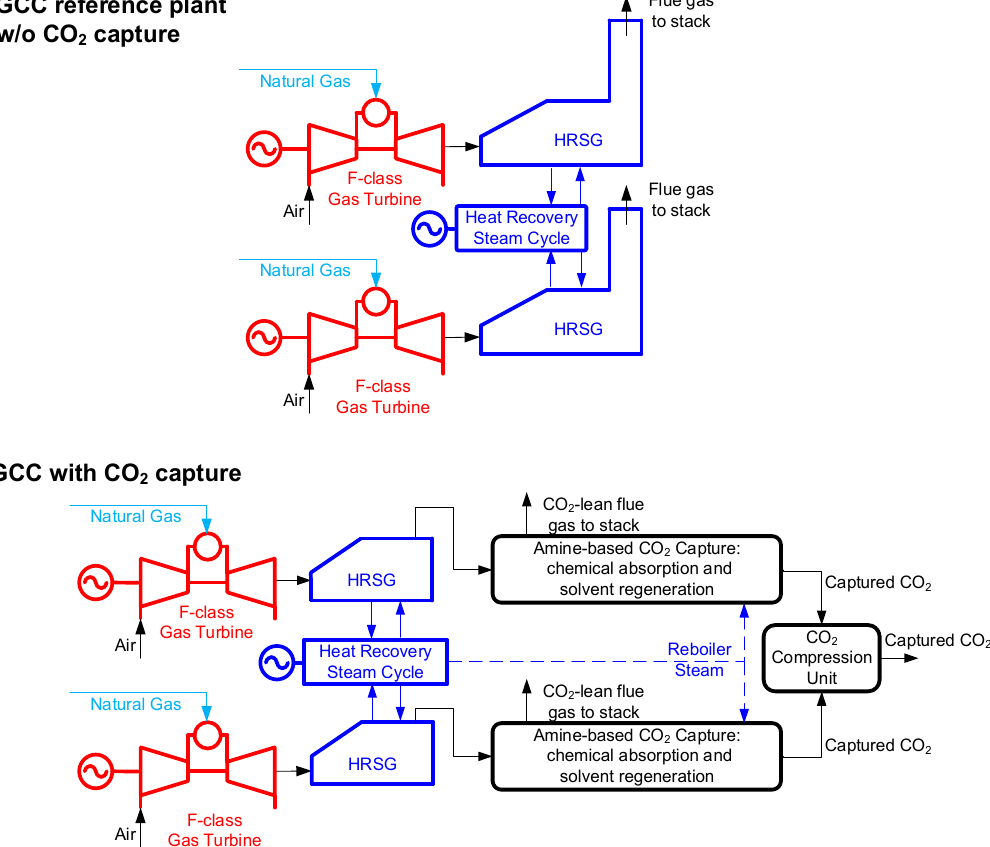
Figure 2. Block-flow diagram of: ( a ) the Reference plant without CO 2 capture and storage (CCS); ( b ) the natural gas combined cycle (NGCC) with CO 2 capture (this general scheme applies both to the Base plant and to the Advanced-piperazine (PZ) plant).